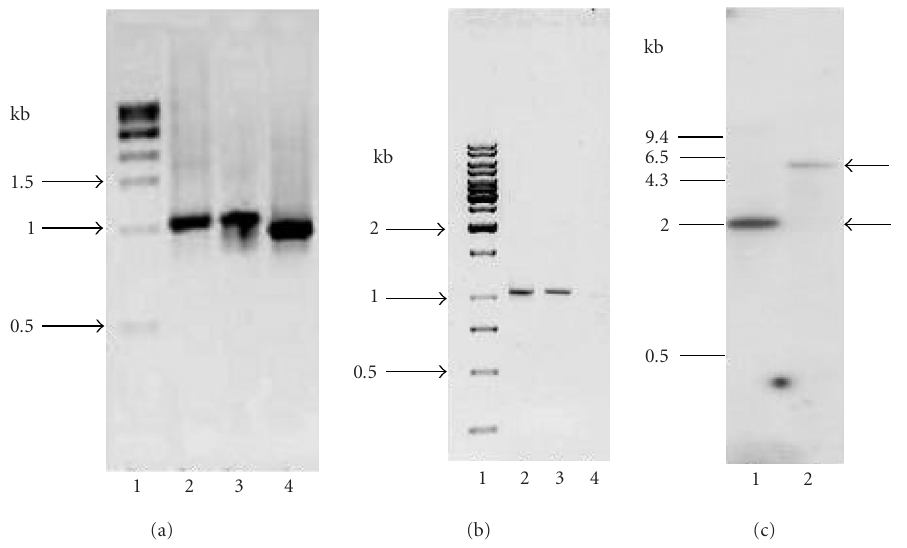
Figure 1. (a) PCR amplified products of di ff erent signal peptidases. The PCR was performed as described in materials and methods and analyzed by agarose gel electrophoresis. Lane 1 is DNA molecular weight marker. Lane 2 is product of P falciparum , lane 3 is P yoelii , and lane 4 is P knowlesi . (b) cDNA analysis of type I signal peptidase of P falciparum . Total RNA isolated from the parasite lysate was used for construction of cDNA and this cDNA was used as template for the amplification of type I signal peptidase as described in materials and methods. Lane 1 is molecular weight marker, lane 2 is PCR product using genomic DNA as template, lane 3 is PCR product using cDNA as template, and lane 4 is PCR reaction without any template. (c) Southern blot analysis of the type I signal peptidase gene of P falciparum . Genomic DNA (20 µ g per lane) from P falciparum was digested with Bgl II (lane 1) and Nde I (lane 2) restriction enzymes, separated by electrophoresis on a 0.8% agarose gel, transferred to a nitrocellulose membrane and hybridized with the type I signal peptidase gene probe of P falciparum . Molecular weight markers are shown on the left side of the autoradiogram and the arrows show the hybridized